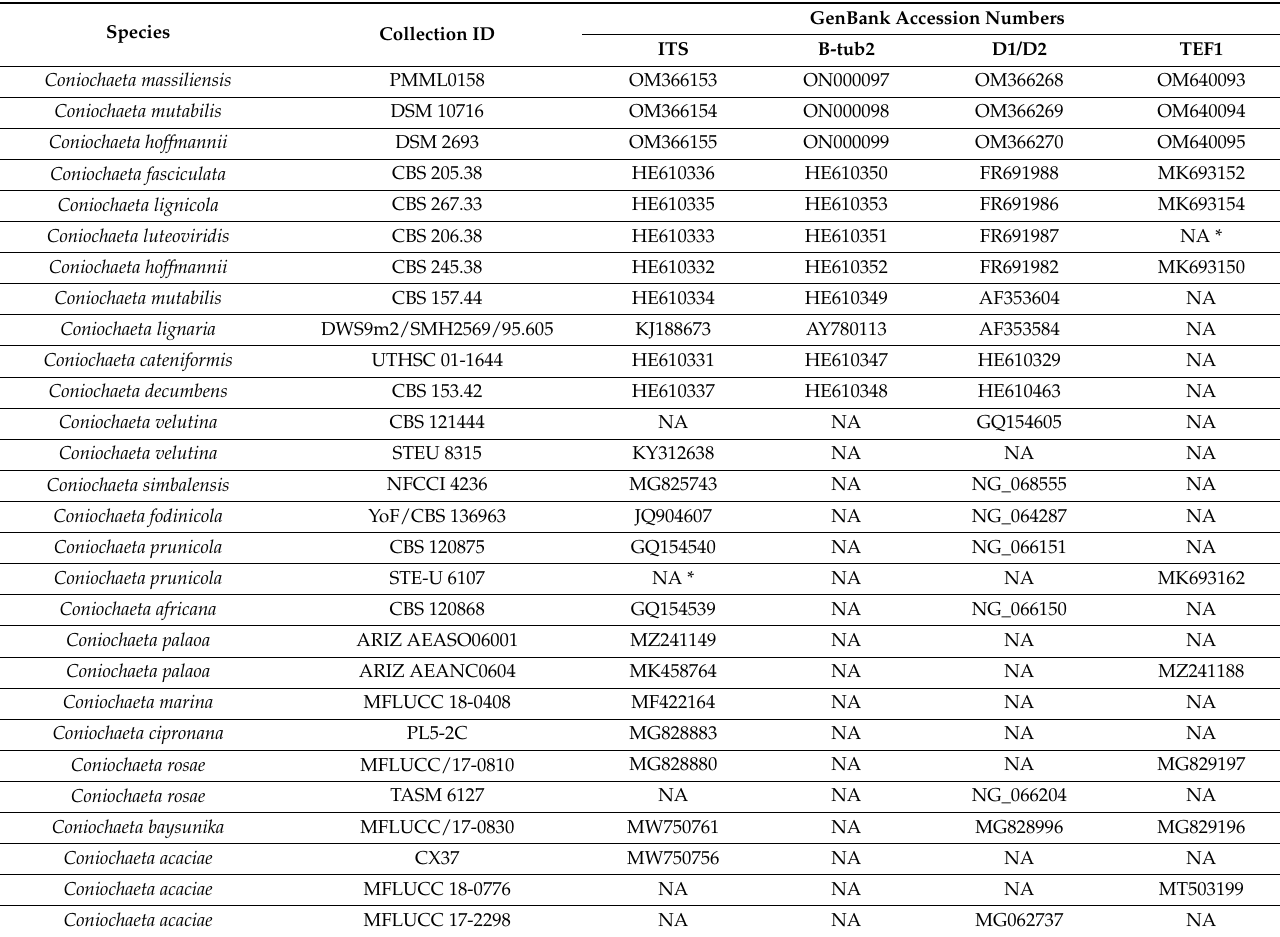
Table 2. GenBank accession numbers of the reference strains used for the phylogenetic